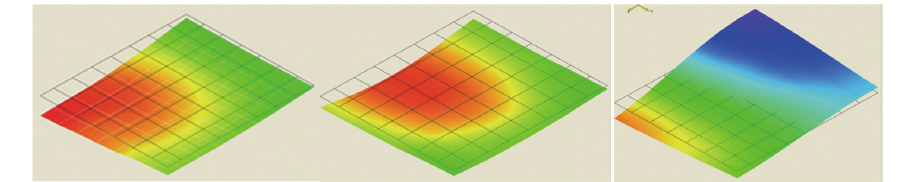
Fig. 9. Mode shapes determined during a fast scan with sine